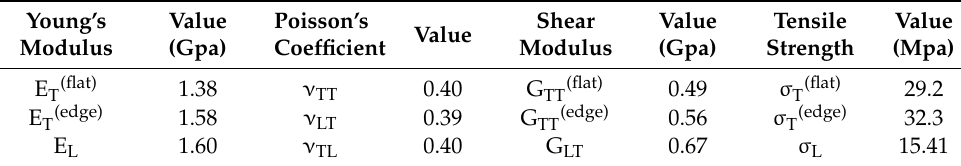
Table 4. Results obtained for each configuration.